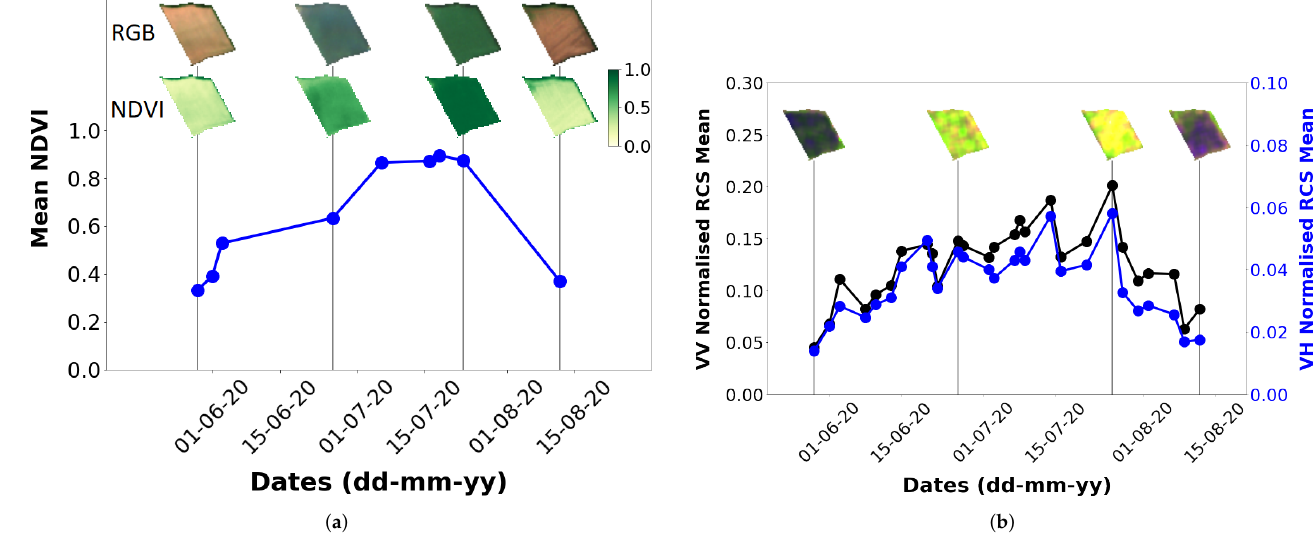
Figure 13. Example of Sentinel-1 and Sentinel-2 multi-temporal attributes from the 29 May 2020 to the 12 August 2020 for a field growing peas in Scotland. ( a ) Mean NDVI trend for Sentinel-2 for the cloud-free acquisitions along with examples of RGB images and NDVI maps. ( b ) Mean of Sentinel-1 VV and VH polarisation normalised radar cross-section (RCS) along with examples of Sentinel-1 false colour composite